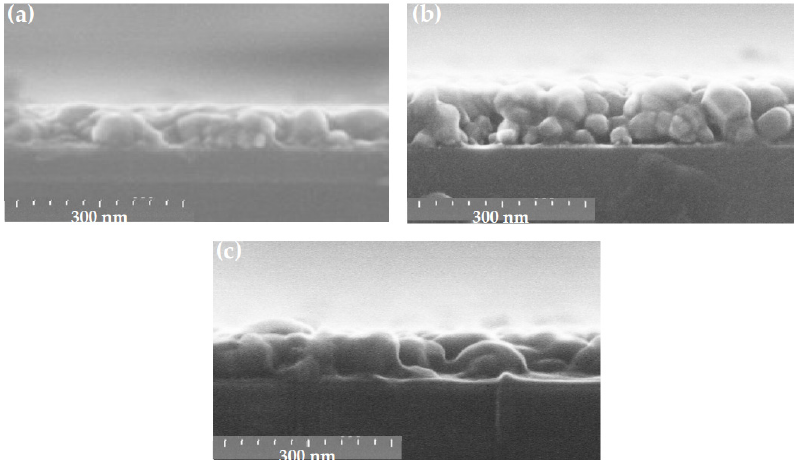
Figure 15. Cross-sectional SEM views of sol-gel spin-coated ZnO samples obtained with 2-methoxyethanol ( a ), ethanol ( b ), and propanol ( c ). Figure 16a,b show AFM micrographs corresponding to samples elaborated with pro- panol and ethanol, respectively. The samples present similar granular aspects with, nev- ertheless, a significant difference in terms of grain size. In the case of ethanol (Figure 16b), the resulting film is porous with large grains. This could be an advantage in applications requiring a reactive surface grade such as photocatalytic activities. The AFM data (lateral size and height) for the different solvents are summarized in Figure 16c. The lateral size, around 45 nm using 2-methoxyethanol or propanol, grows to 55 nm with ethanol. The AFM height increases from 35 nm with 2-metoxyethanol and propanol to 60 nm with eth- anol, in agreement with the increase in film thickness (see Figure 15), which will also be confirmed by ellipsometry measurements. The particular morphology, with large voids between neighboring grains, obtained in the case of ethanol (Figure 16b) would be a con- sequence of a relatively high deposition rate, which would favor the formation of large grains to the detriment of a relaxation of agglomerates and a densification of the layer. The XRD spectra of ZnO thin films obtained with various solvents are displayed in Figure 17. The sample obtained with 2-methoxyethanol shows a high-intensity (002) peak with almost no (100) and (101) peaks. Using propanol or ethanol, peaks (100) and (101) appear on either side of the high-intensity (002) peak, suggesting a lower crystallinity quality. The intensity ratio of the (100) peak to the (002) peak is 0.2 for propanol and 0.1 for ethanol, whereas it is less than 10 − 2 for 2-methoxyethanol. Using the (002) peak, Scher- rer formula gives a mean crystallite size of around 35 nm for all solvents.